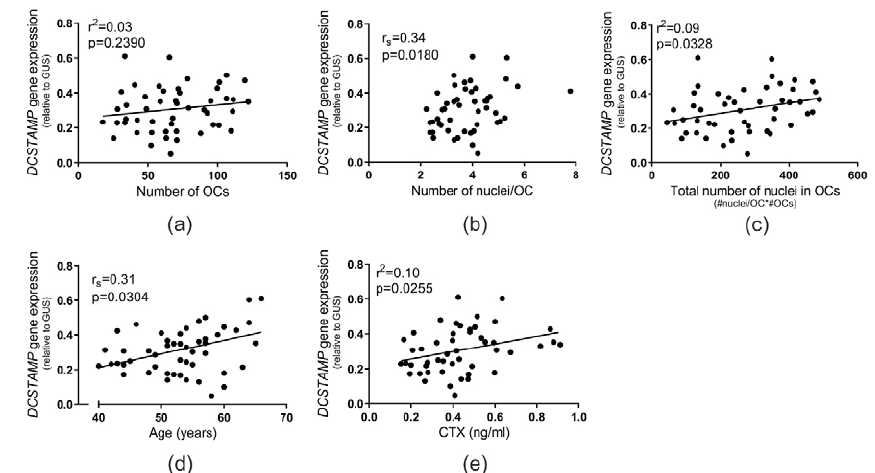
Figure 5. DCSTAMP expression levels of OCs in vitro increases with donor age, increased bone resorption activity (CTX) in vivo, and the fusion potential of in vitro-generated OCs. The relation between the gene expression of DCSTAMP in OCs in vitro and ( a ) the mean number of OCs (per vision field), ( b ) the mean number of nuclei per OC, ( c ) the total number of nuclei in OCs, ( d ) age (reproduced from: Møller et al. 2020 [17] with permission of Bone Research published by Springer Nature, 2020), and ( e ) the level of CTX in vivo. Statistics: correlation analyses were performed using either Spearman’s rank correlation (r s ) in ( b , d ) or Pearson’s correlation (r 2 ) in ( a , c , e ). Each point represents the results obtained from OCs generated from an individual donor ( n = 49). “#”, number; “*”, multiplied by.